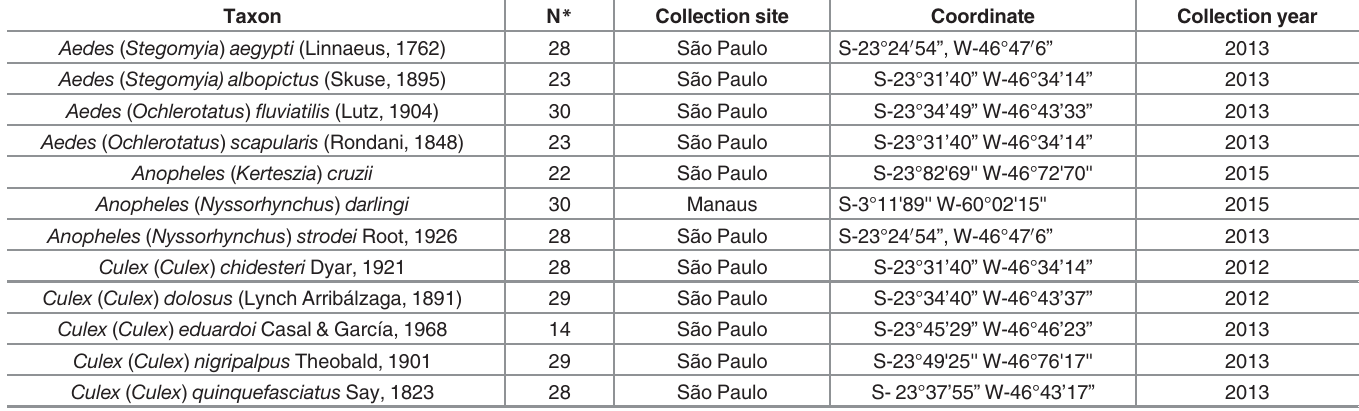
Table 1. Mosquito species, collection sites and geographic